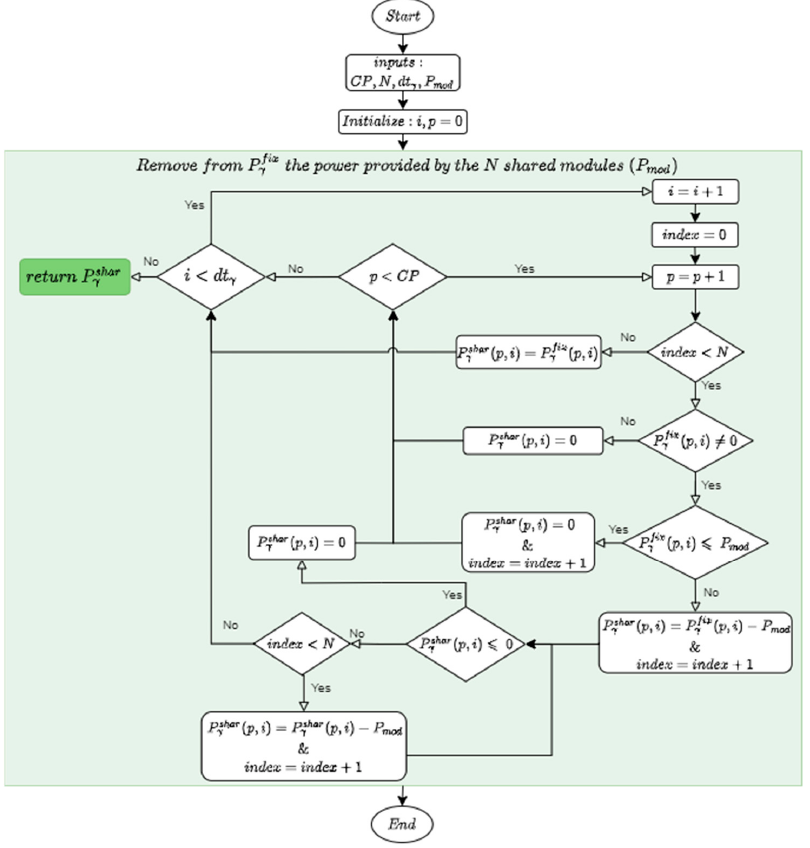
Figure 8. Flowchart to get the penalty cost.